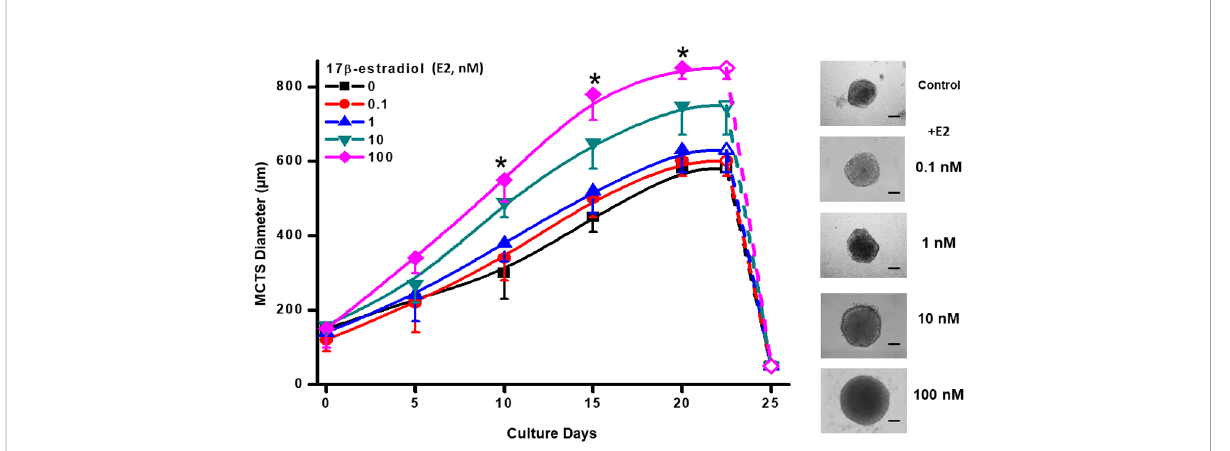
FIGURE 1 Effect of E2 on MCF-7 MCTS growth. The right panel shows contrast phase microscope images taken at day 20, which display the typical different MCTS sizes in the presence of exogenous E2. Scale Bar= 200 µm. Data shown represent the mean ± S.D. of at least 3 different independent preparations, n=30-40 spheroids. *P <0.05 vs. 10 and 100 nM of E2. E2, 17 b